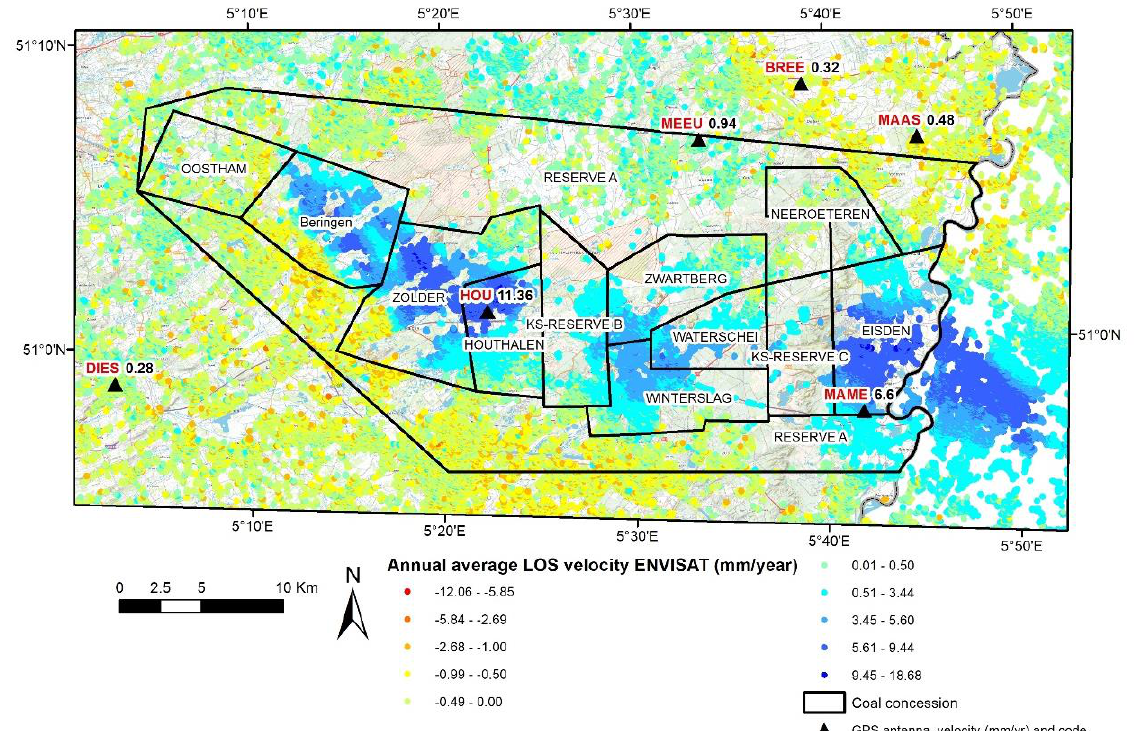
Figure 16. Color classification based on the average annual LOS velocities of PS points for ENVISAT, superimposed with the extension of coal concessions in Limburg and the localization of the GNSS antennas (red abbreviation) with their vertical velocities in a mm/year format (in black).